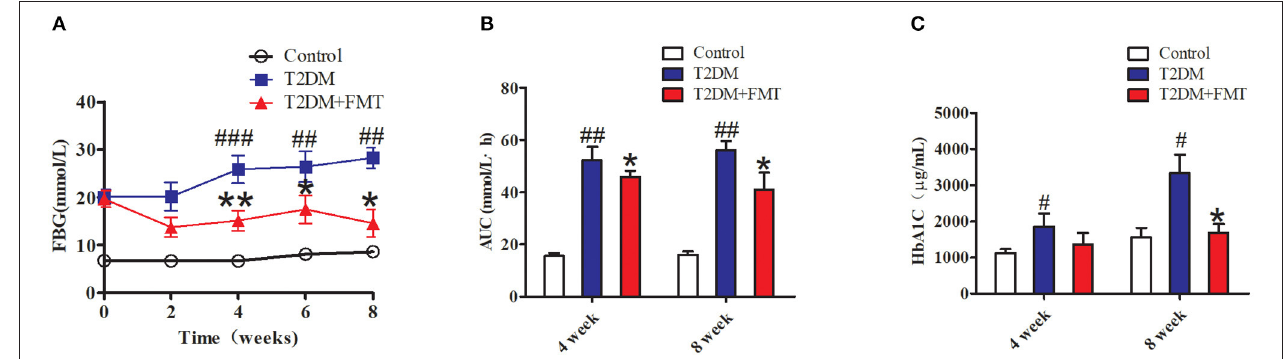
FIGURE 1 | The effect of FMT on hyperglycemia inT2DM mice. (A) Relative levels of FBG on different groups during the experiment period. (B) Effect on the areas under the curve of glucose (AUC). Mice were administrated 20% glucose (2 g/kg) and blood glucose was tested in 0, 30, 60, 120min. AUC = 1/2 × [0.5 × (FBG 0